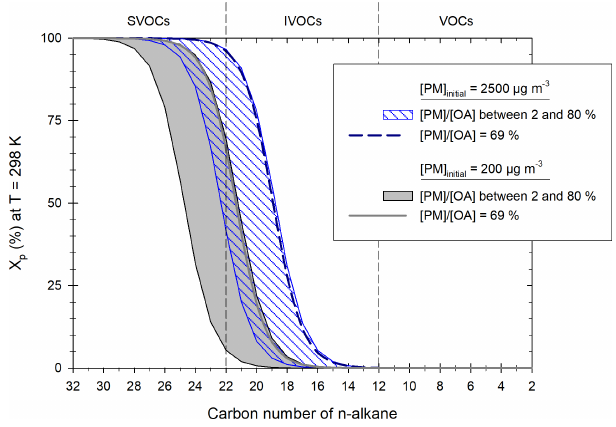
Figure G1. Particle fraction at T = 298K of n-alkanes (VOCs, IVOCs and SVOCs), in percentage, with carbon number between 2 and 32. The repartition is given assuming two initial PM concen- trations of 200µgm − 3 (grey) and 2500µgm − 3 (blue), typical of significant [PM] increase. X p is computed with different estimates of organic aerosol concentrations [OA], ranging from 2% to 80% of initial [PM] (grey area and blue hatched area, respectively). It is also computed assuming that [OA] = 69% of initial [PM], with initial [PM] of 200µgm − 3 (continuous grey line) and 2500µgm − 3 (dashed blue